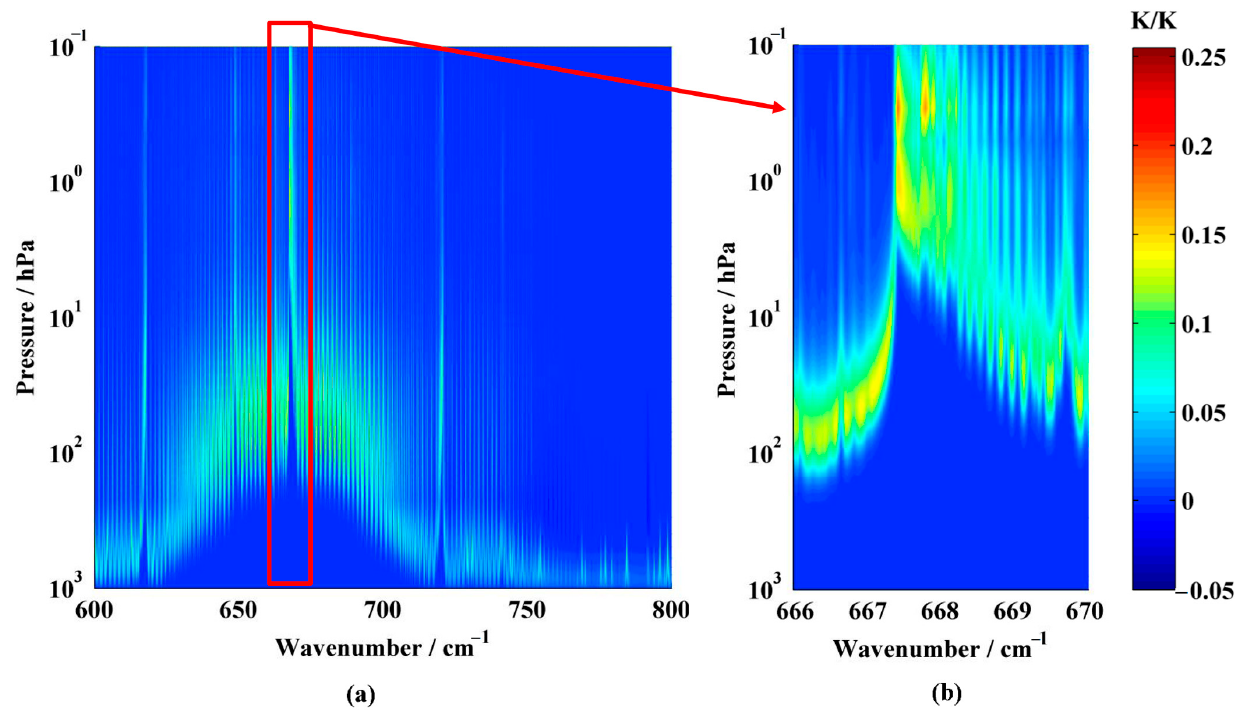
Figure 3. The temperature Jacobians. ( a ) The spectral region of 600–800 cm − 1 with a spectral resolution of 0.03 cm − 1 . ( b ) The spectral region of 666–670 cm − 1 with a spectral resolution of 0.03 cm − 1 .